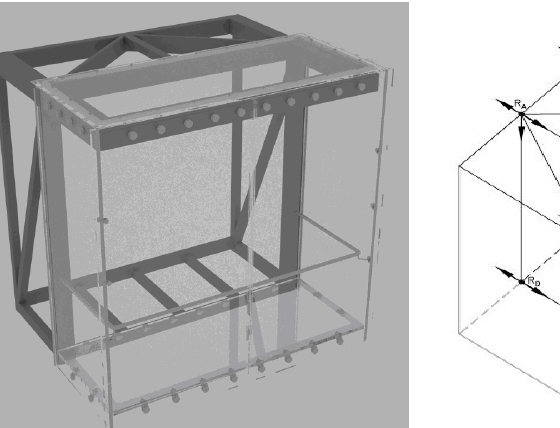
Figure 4: Glass Observation Box Steel Framing Rendering.